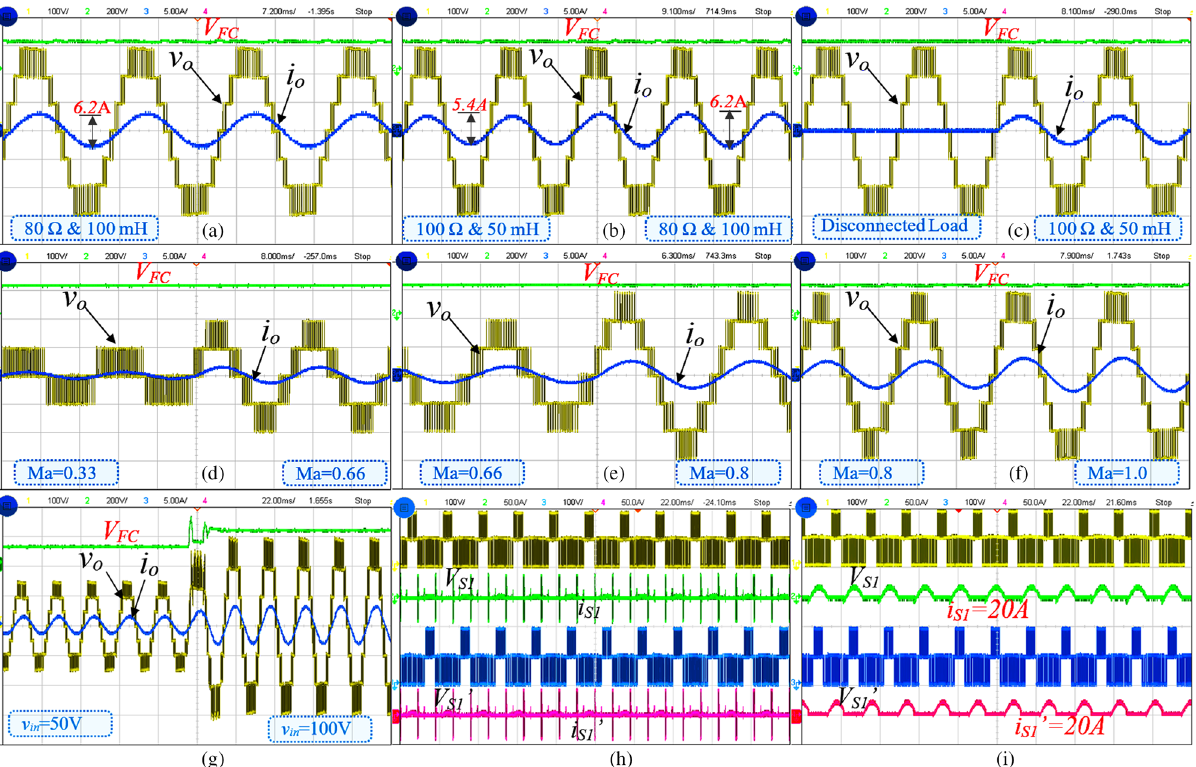
Figure 6. Experimental results of proposed 7L boost type ANPC Inverter, ( a ) output voltage and current, ( b ) sudden load changes from 100 Ω and 50 mH to 80 Ω and 100 mH, ( c ) no-load to 100 Ω and 50 mH, modulation index (Ma) variations ( d ) 0.33–066, ( e ) 0.66–0.8, ( f ) 0.8–1.0, ( g ) sudden input voltage changes from 50 to 100 V, Switch (S 1 and S 1 ′ ) voltage and current ( h ) without loop inductor and ( i ) with loop inductor.